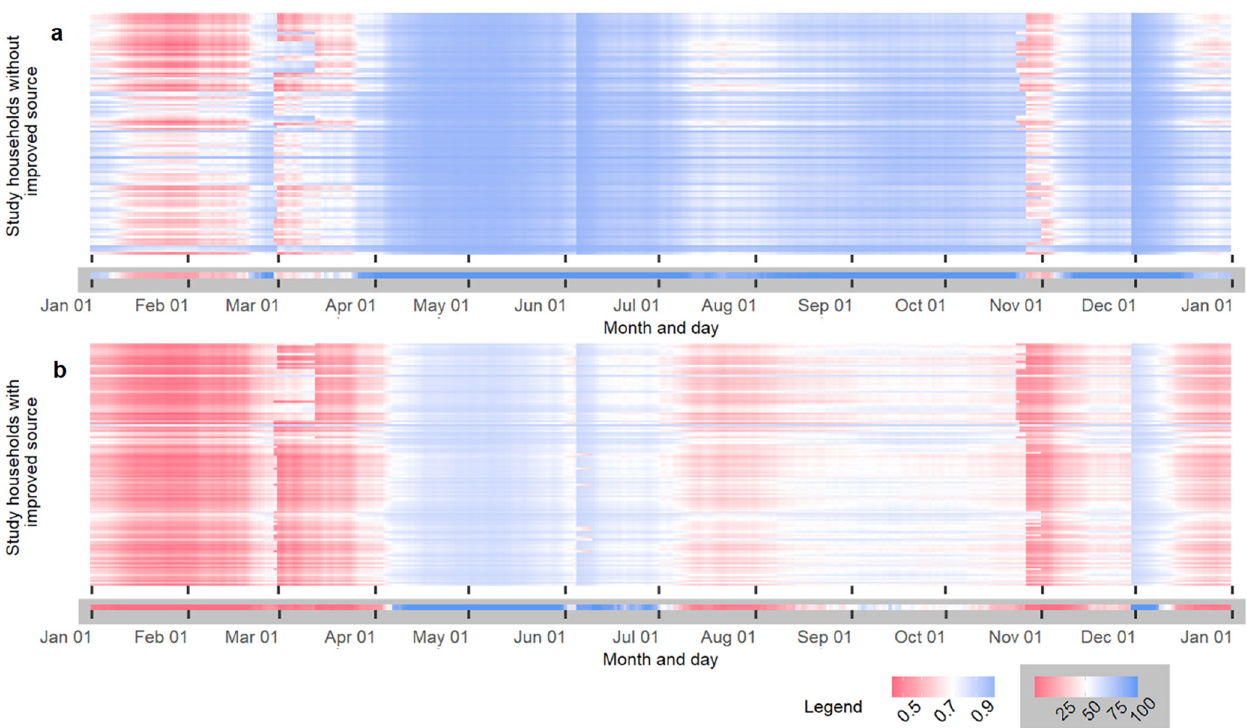
Fig. 6 Heat map of predicted availability of rainwater stored at home, broken down by household access to alternative improved water sources. In the upper heat maps, each column represents a day (of a year), and each row represents a study household. Predicted probability was scaled from red (NOT AVAILABLE: smaller than the optimal cutoff value of 0.767 (in white), selected by maximising the sum of sensitivity and speci fi city) to blue (AVAILABLE: greater than 0.767). The lower inset bars (with a grey background) show the percentage of all households without ( a ; n = 101) and with ( b ; n = 123) alternative improved water sources that had harvested rainwater available at home on a given day of a year, scaled from red (less than the 50 percent threshold as shown in white) to blue (greater than 50